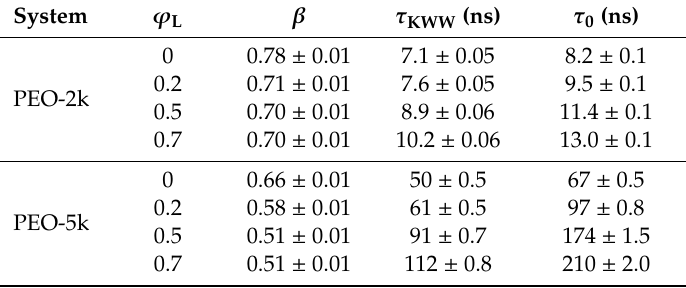
Table 2. Molecular dynamics (MD) predictions for the values of the characteristic stretching exponent β , KWW relaxation time τ τ KWW , and total correlation time 0 quantifying terminal relaxation of rings in the simulated blends. For direct comparison, we also report the corresponding data for rings in their own melt from Ref. [25].